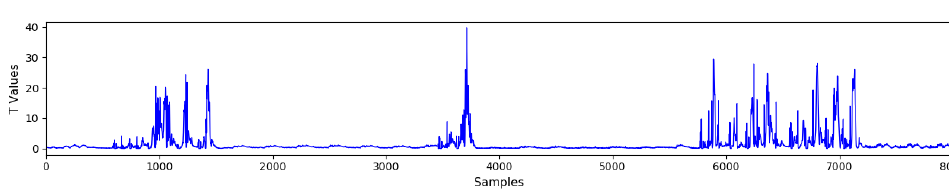
Figure 3: The result of CLA for Cswap-Arith: the leakage metric